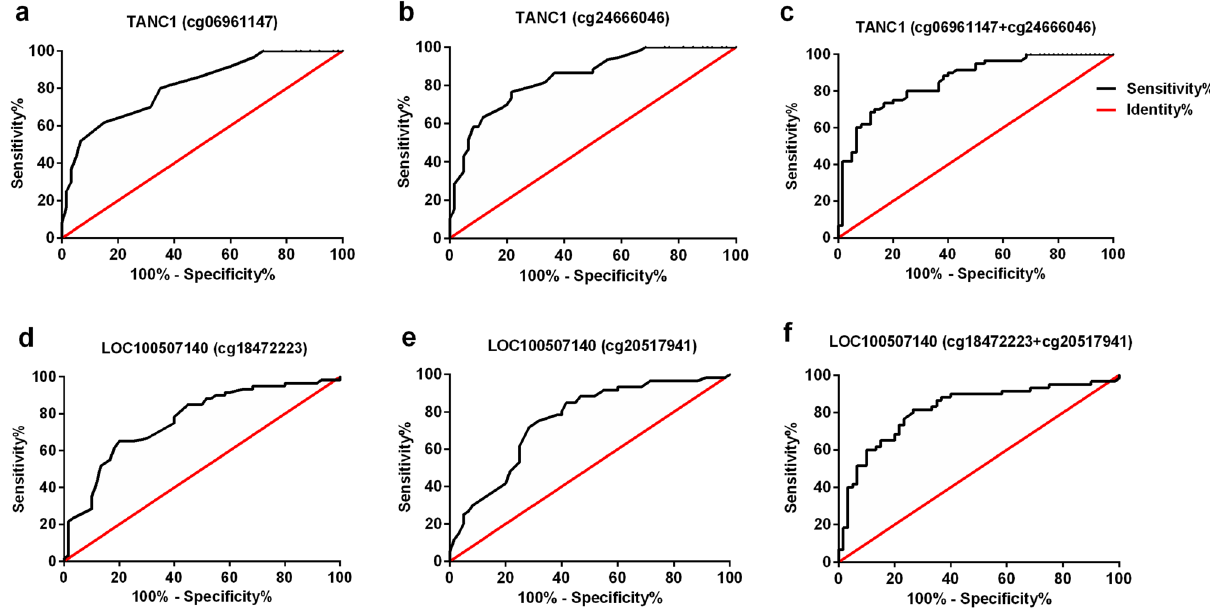
Figure 7. The receiver operating characteristic (ROC) curve for the discrimination of ADLI and non-ADLI. ROC curves were generated for cg06961147 (a) , cg24666046 (b) , and in combination (c) of the TANC1 gene. ROC curves of the cg18472223 (d) , cg20517941 (e) , and combination (f) of the LOC100507140 gene were also